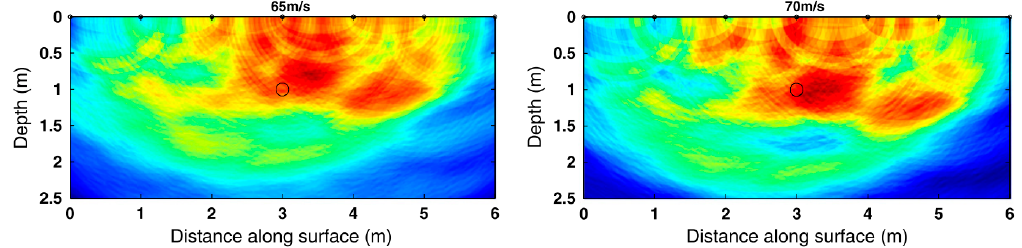
Figure 15. Cross-sectional image produced from shear wave method using two different wave speeds. The black bold line shows the location of the target [102], Copyright Elsevier, 2014.